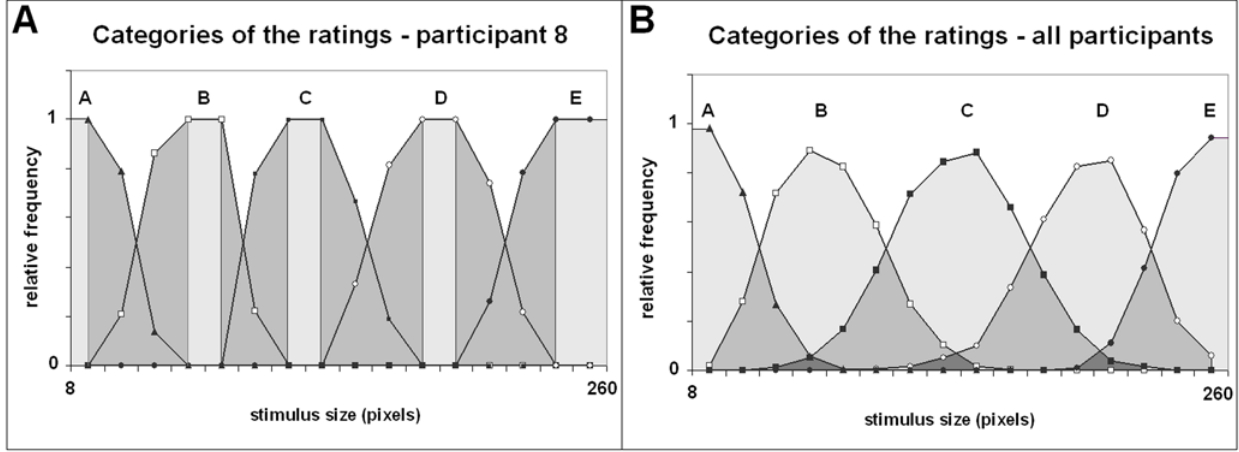
Figure 2. Categories of the ratings. Each category corresponds to a curve. Horizontal : stimulus size (diameter in pixels). Vertical : relative frequency. a) One participant. Light gray : cores. Dark gray : peripheries. b) Whole group. Note: the cores of central categories are reduced to a single peak.